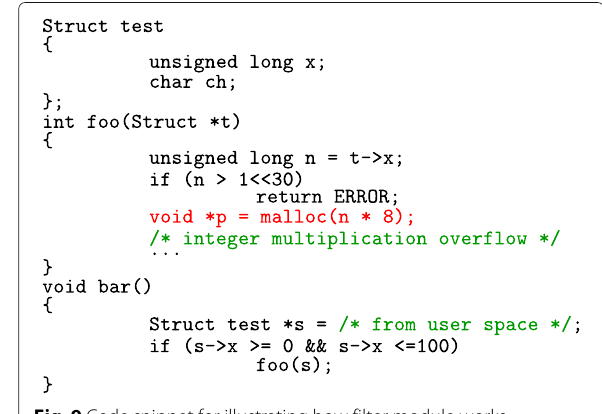
Fig. 9 Code snippet for illustrating how filter module works